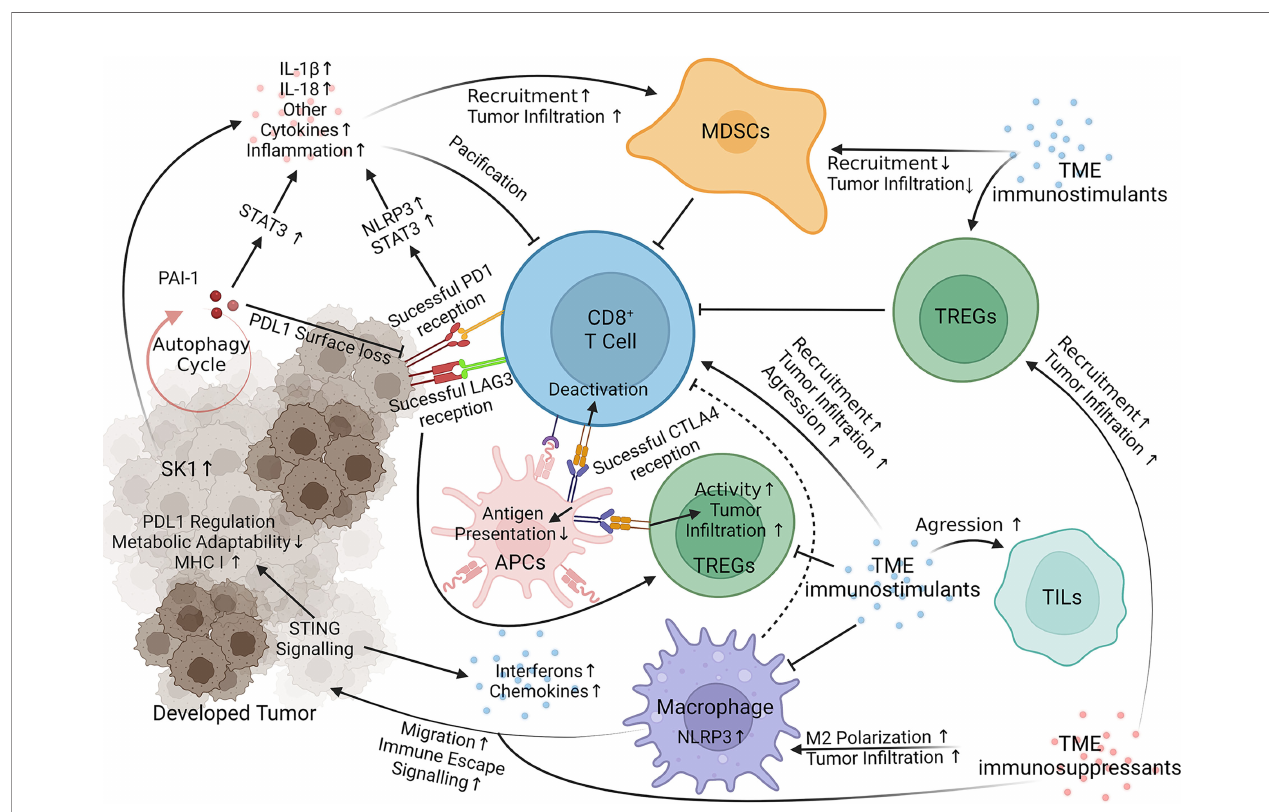
FIGURE 1 | Immunotherapy Resistance Signaling. Key targets of interest negate therapeutic responses through internal melanoma pathways, acquisition of TME `immunosuppressants (red) and loss of TME immunostimulants (blue). STING, Stimulator of Interferon Genes; NLRP3, Nucleotide-binding domain, leucine-rich containing family, pyrin domain-containing-3; PAI-1, Plasminogen Activator Inhibitor-1; LAG3 (Green on T Cell), Lymphocyte-activation gene 3; SK-1, Sphingosine kinase 1; PD1, Programmed cell death protein 1 (yellow on T Cell); CLTA4, Cytotoxic T-Lymphocyte Associated Protein 4 (Blue on APC); STAT3, Signal transducer and activator of transcription 3; IL, interleukin; MDSCs, Myeloid-derived suppressor cells; TREGs, Regulatory T cells; TILs, Tumor-in fi ltrating lymphocytes; APCs, Antigen Presenting Cells (45, 56 – 78). Visualization created with BioRender.com.